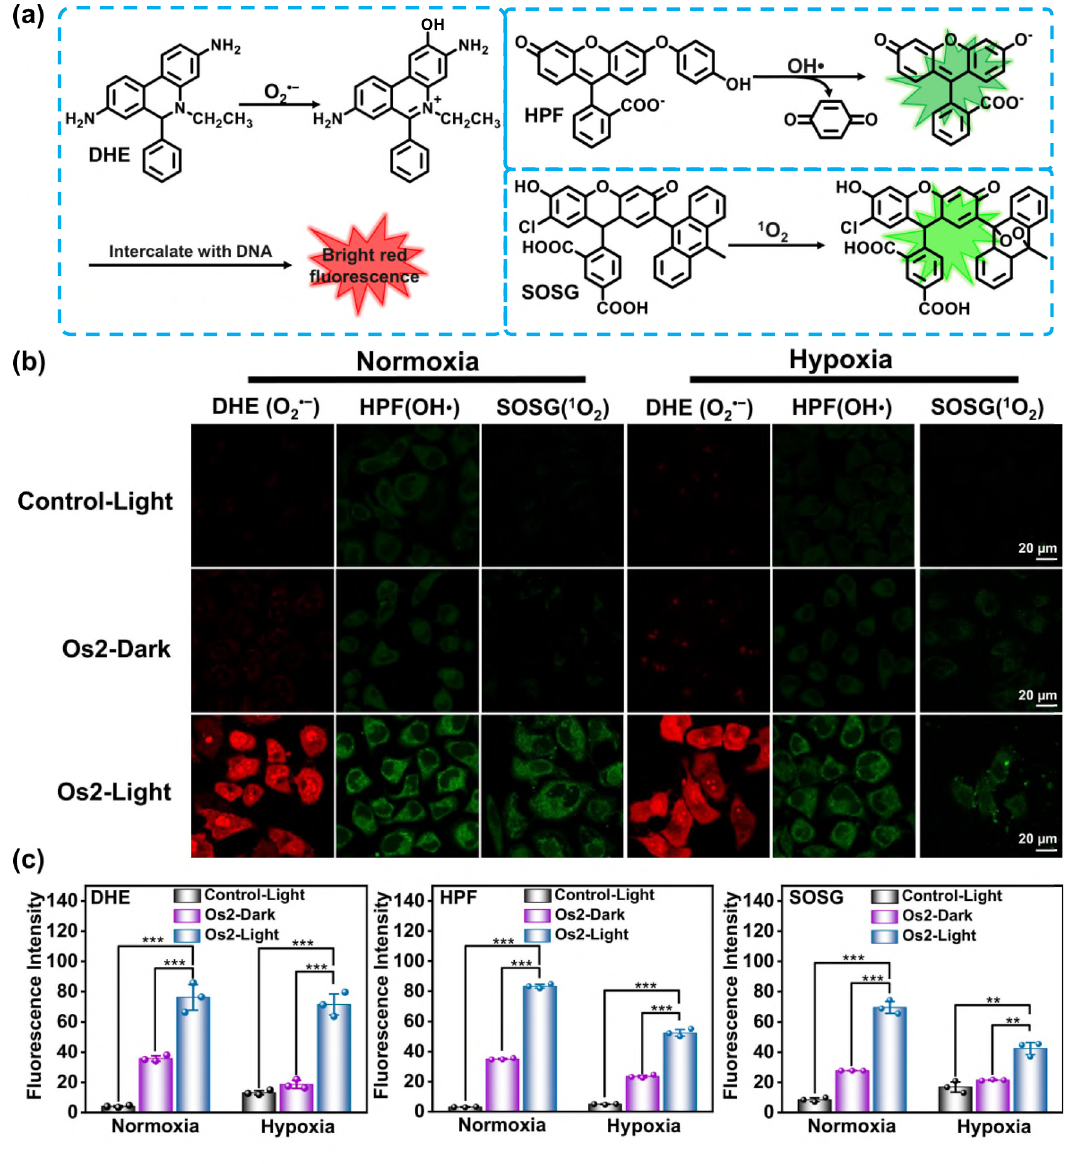
Fig. 3 Cellular ROS mesurement. a Schematic diagram of detection of O 2 (cid:129) − , OH (cid:129) and 1 O 2 with DHE, HPF and SOSG probes, respectively. b Confocal microscope images of O 2 (cid:129) − , OH (cid:129) and 1 O 2 in HeLa cells under normoxia (20% O 2 ) or hypoxia (1% O 2 ) probed by DHE, HPF and SOSG, respectively. c The average fl uorescence intensities calculated from the images in b . All experiments were repeated three times independently with similar results. Error bars represent S.D. from the mean. Statistical signi fi cance was calculated with two-tailed Student ’ s t test (* p < 0.05, ** p ≤ 0.01 or *** p ≤ 0.001). HeLa cells incubated with Os2 (20 μ M) for 8 h, and then treated with DHE (10 μ M, 30 min), HPF (10 μ M, 1 h) or SOSG (2.5 μ M, 30 min). Incubation temperature: 310 K; Light irradiation: 465 nm, 13 mW/cm 2 , 1 h; DHE: λ ex = 488 nm, λ em = 600 ± 30 nm; HPF: λ ex = 488 nm, λ em = 530 ± 30 nm; SOSG: λ ex = 488 nm, λ = 525 ± 30 nm. DHE dihydroethidium; HPF hydroxyphenyl fl uorescein; SOSG singlet oxygen sensor em